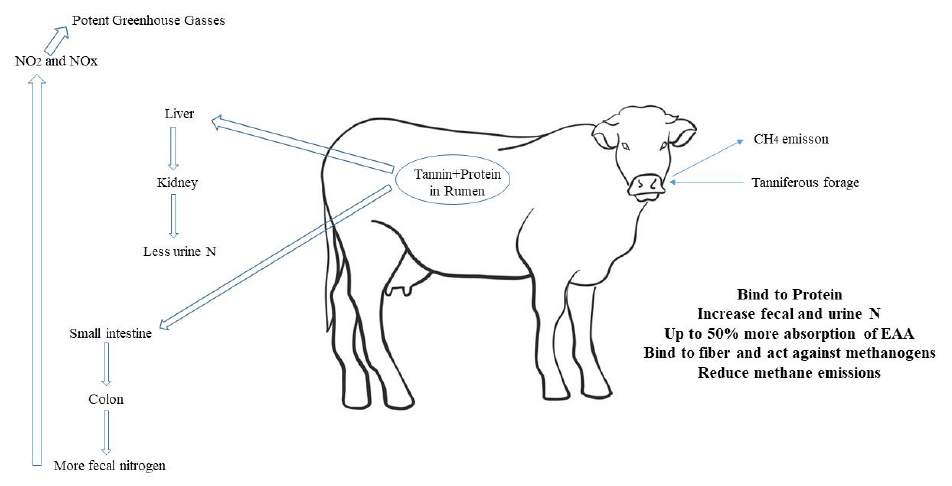
Figure 3. Main effect of tannins binding proteins in rumen .